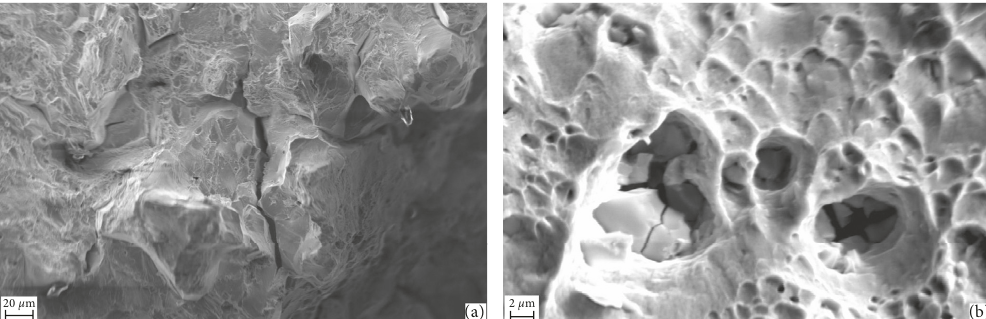
Figure 8: Fracture surface investigation of Ni alloy specimen with cumulation of failure due to static loading at 293K in hydrogen under the pressure of 30 MPa: (a) intergranular fracture in the area of surface cracks and (b) destruction along the boundary of the carbide matrix with carbide